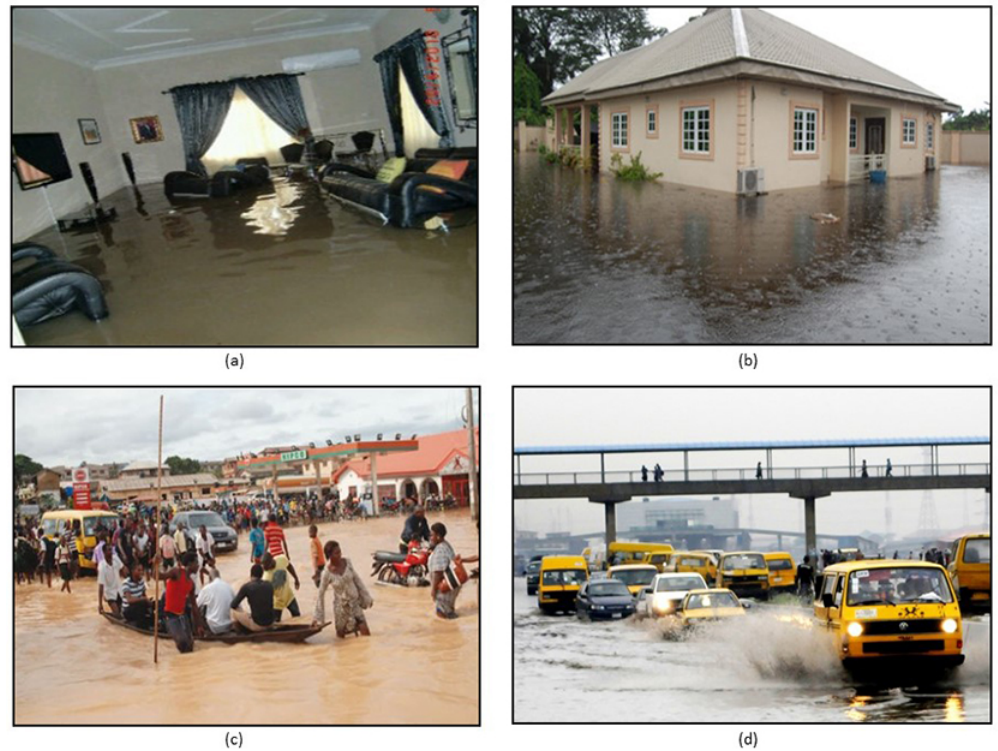
Figure 5. Some flooding scenes examples in the Lagos metropolis of Nigeria: (a) living room submerged by flood water, (b) residential building submerged, (c) local community affected by flood waters, and (d) expressway overwhelmed by flood water. Source: Online images of flooding in Lagos,